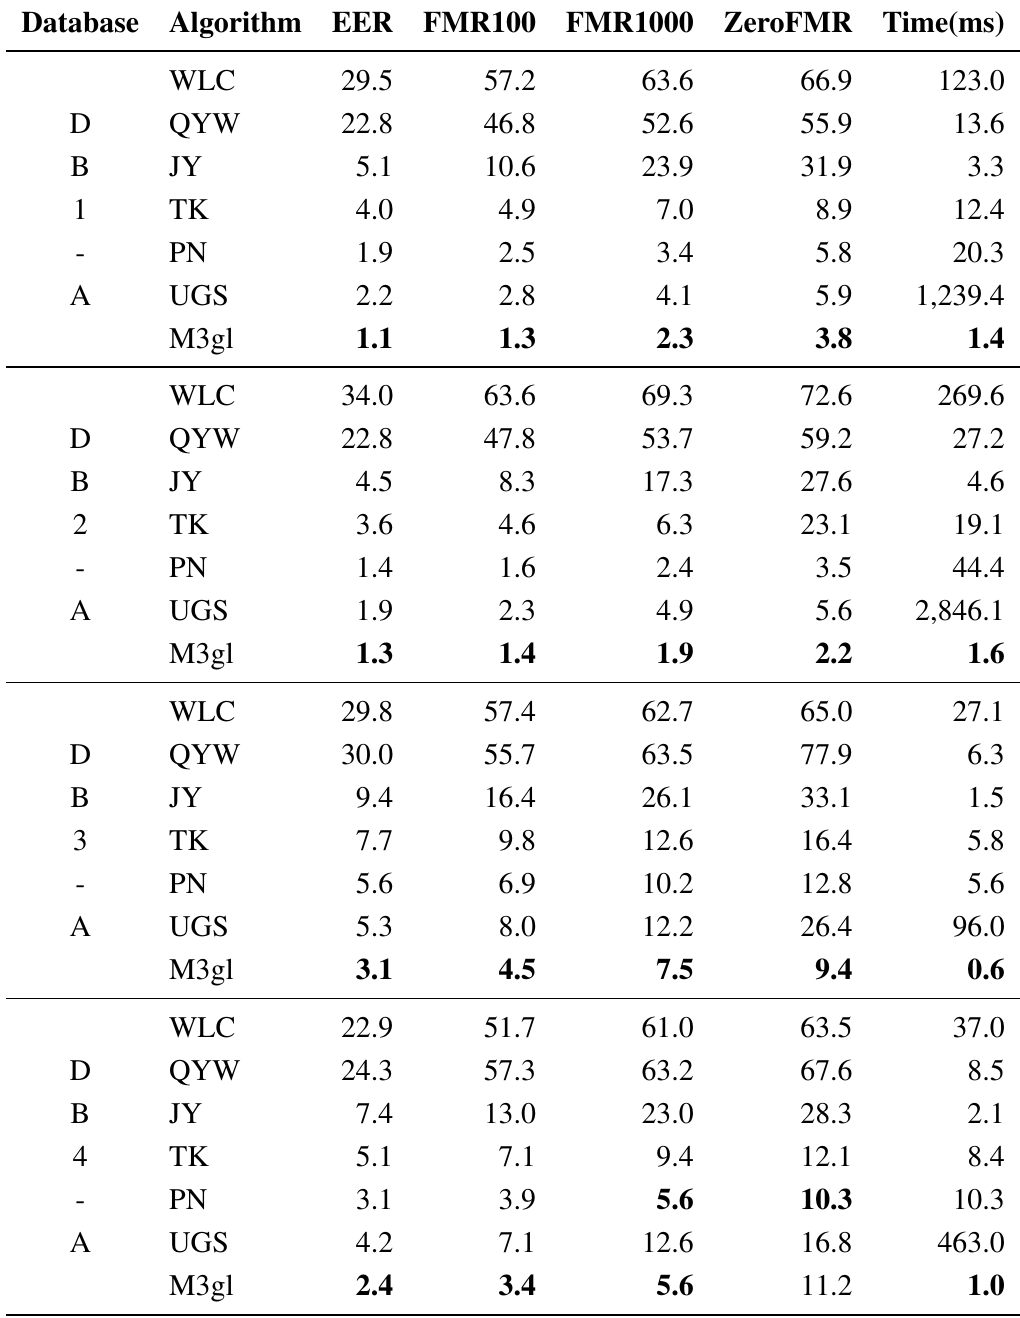
Table 2. Experimental results on databases DB1 A, DB2 A, DB3 A and DB4 A of